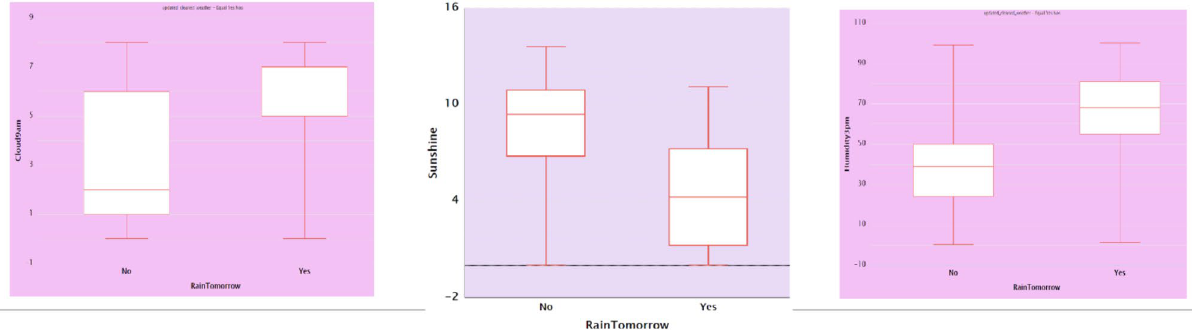
Figure 6. Box plots between significant features.